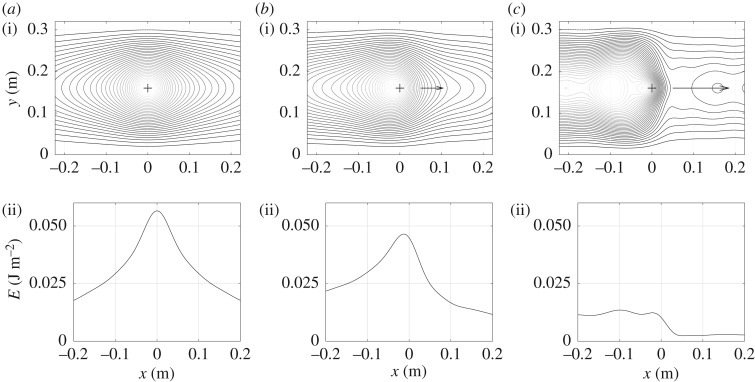
Repartition of Eulerian vibrational energy Ed near the moving point force at f = 200 Hz for various moving speeds. Isovalues of energy (i) and energy versus position along the horizontal line y = 0.16 (ii): (a) V = 0 km h−1, (b) V = 90 km h−1 and (c) V = 216 km h−1.